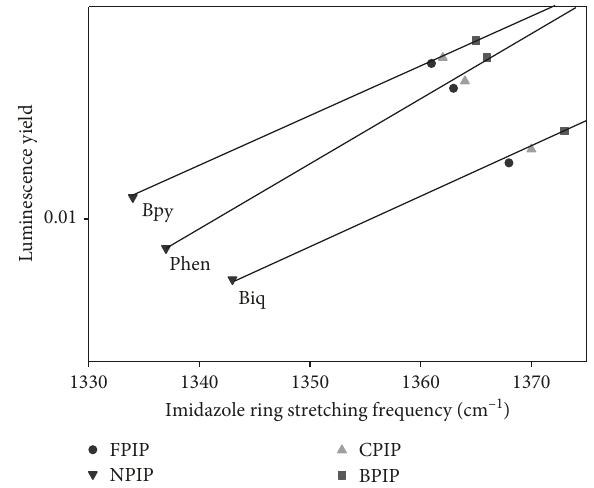
2+ recorded at 2 L] Figure 7: Imidazole stretching frequency against the luminescence yield. Linear fit is a guide for the eye.